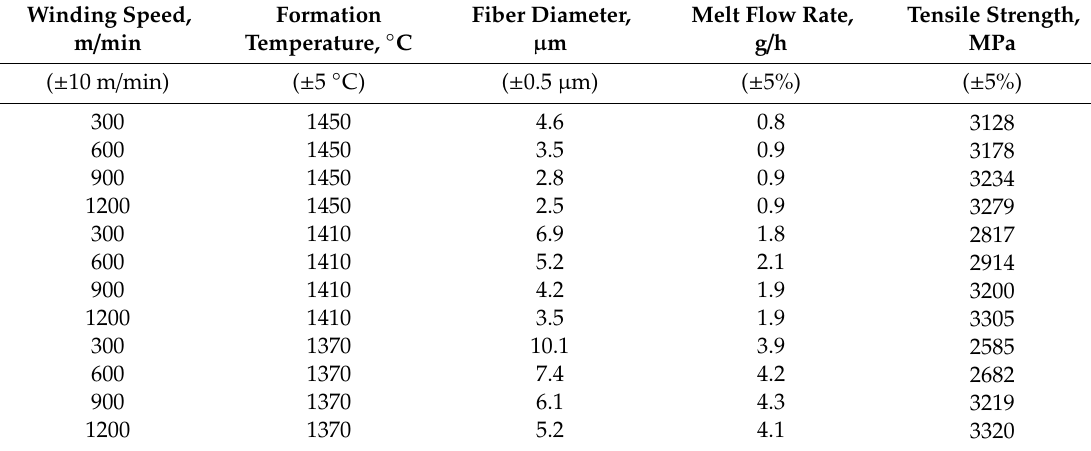
Table 4. Tensile strength of the fibers obtained under di ff erent process parameters using nozzle 4 (diameter 1.5 mm).